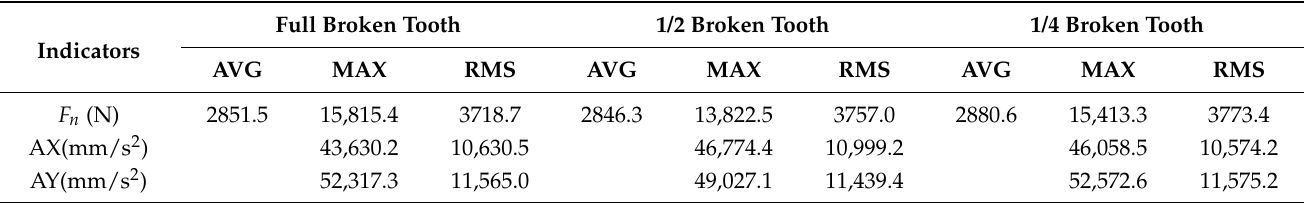
Table 3. Parameters in time domain in different fault states.